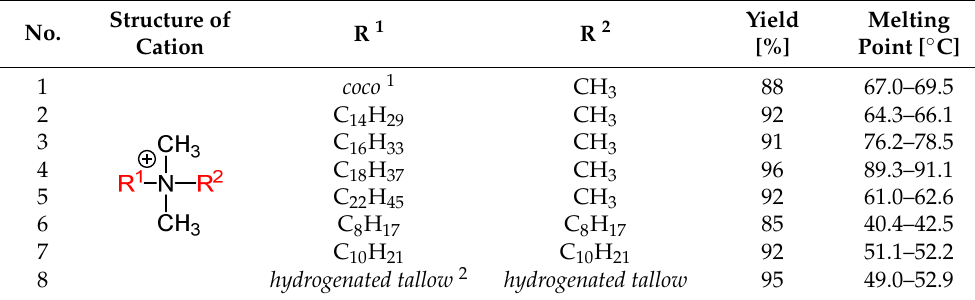
Table 1. Synthesized iodosulfuron-methyl-based salts with commercial tetraalkylammonium cations ( 1 – 8 ).